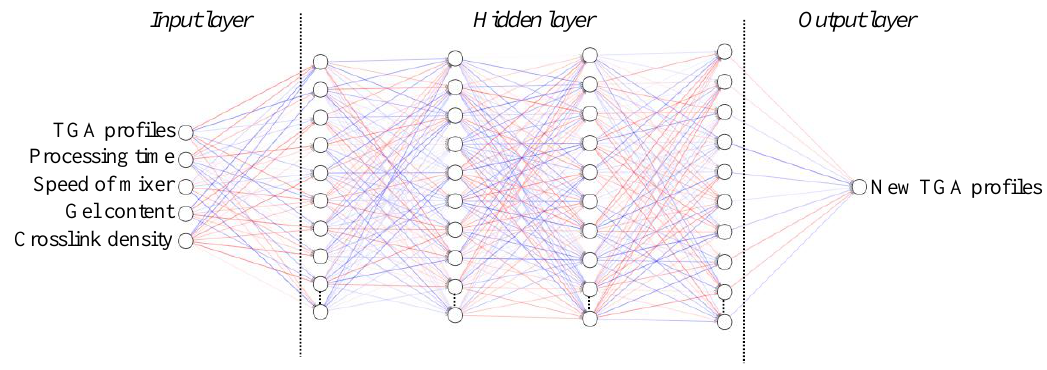
Figure 1. Scheme of the ANN used.